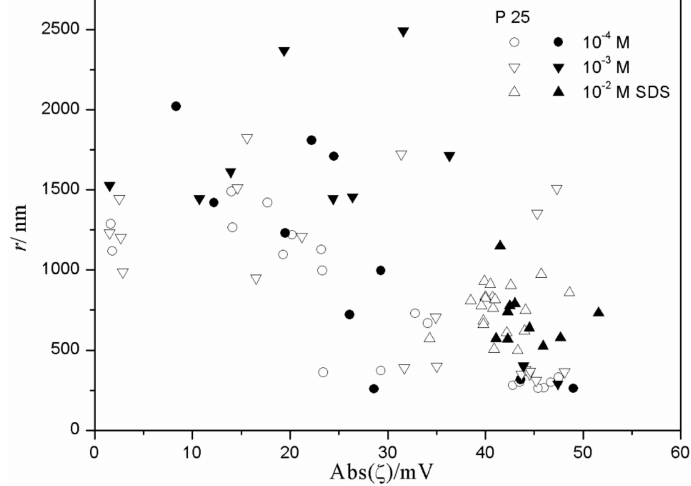
Figure 11. The particle size as a function of | ζ | in fresh (white points) and aged (black points) dispersions of titania in the presence of sodium dodecylsulfate.